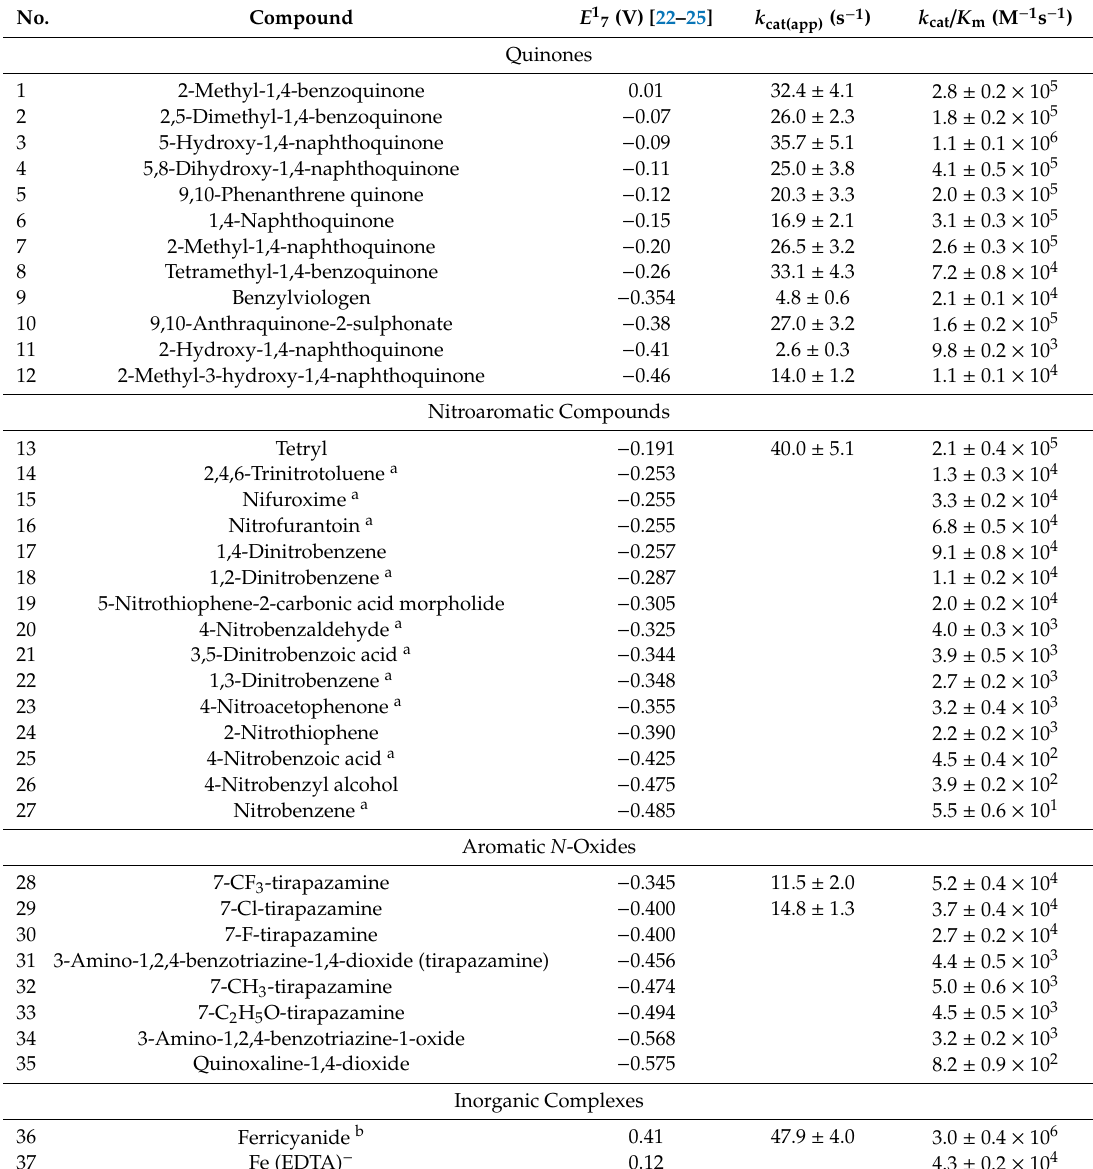
Table 1. Steady-state rate constants of the reduction of nonphysiological electron acceptors by NADPH catalyzed by Pf FNR. (NADPH) = 100 µ M, 0.1-M K-phosphate + 1.0-mM EDTA, pH 7.0, 25 ◦